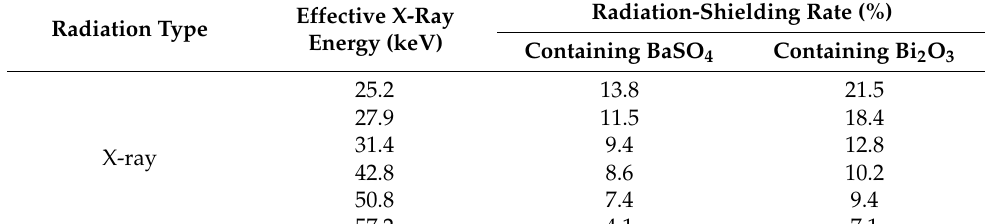
Table 4. Shielding performance of the shielding fiber fabrics.